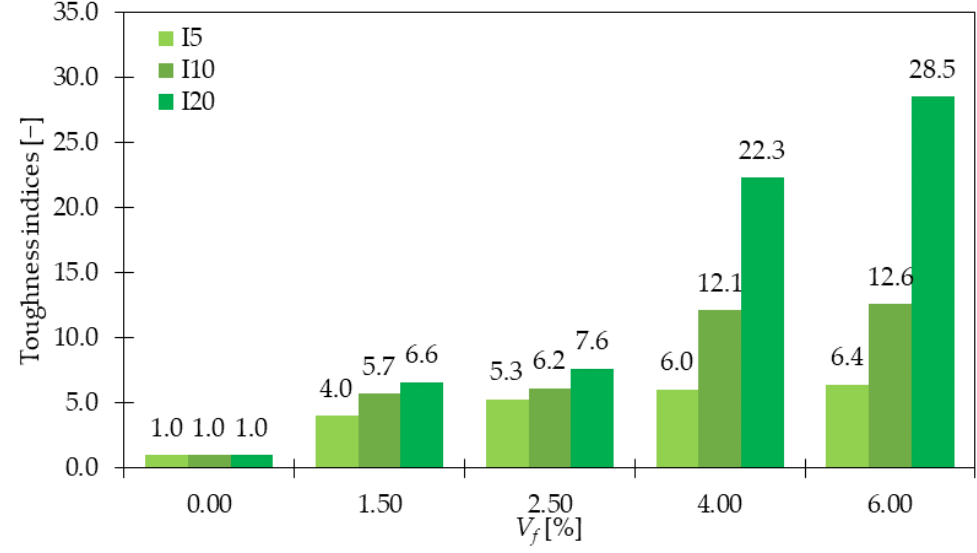
Figure 16. Toughness indices: I 5 , I 10 , and I 20 in relation to V f [32].